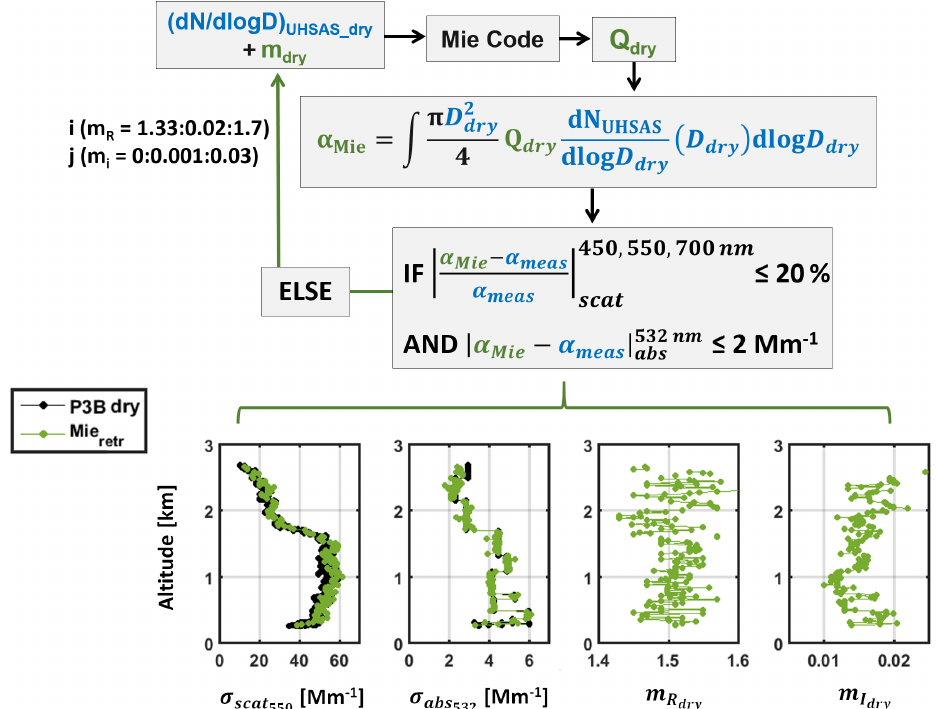
Figure 2. Diagram representation of part I in which the dry complex refractive index pairs ( m R measurements. UHSAS measurements of size distributions are obtained for particles with D < 1µm while the scattering and absorption measurements were obtained for particles with D < 5µm. The blue terms in the block diagram refer to measured quantities. Q dry refers to the scattering or absorption efficiencies calculated with the Mie code. The profiles shown at the bottom of this figure were obtained over Channel View, Houston, TX on 11 September 2013 between 21:06 and 21:15UTC, during DAQ TX. The plots show the comparison between the in situ measurements (“P3B dry” in black) and the retrieved (“Mie retr ”) dry scattering at 550nm ( σ scat 532nm ( σ abs ) obtained with the complex refractive index retrieved in this 532